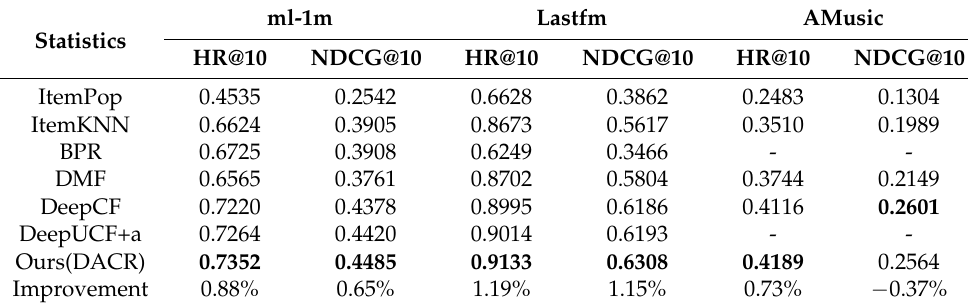
Table 2. Comparison of evaluation for different models.